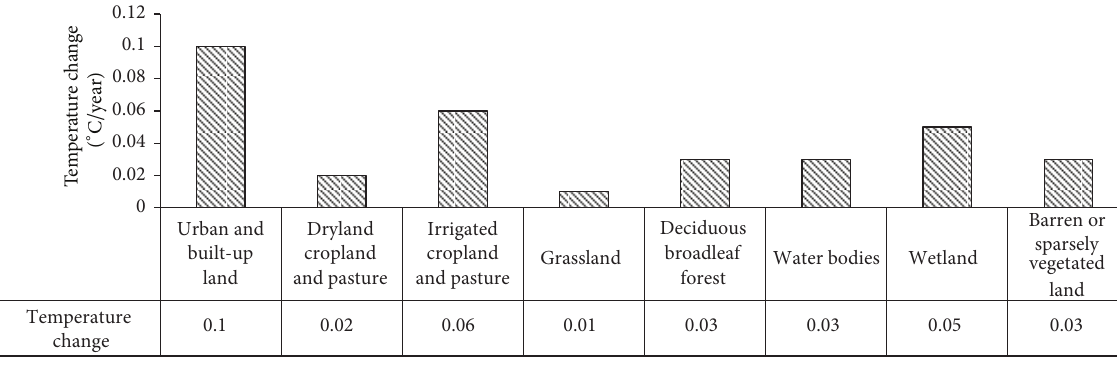
Figure 9: Temperature change in various land cover